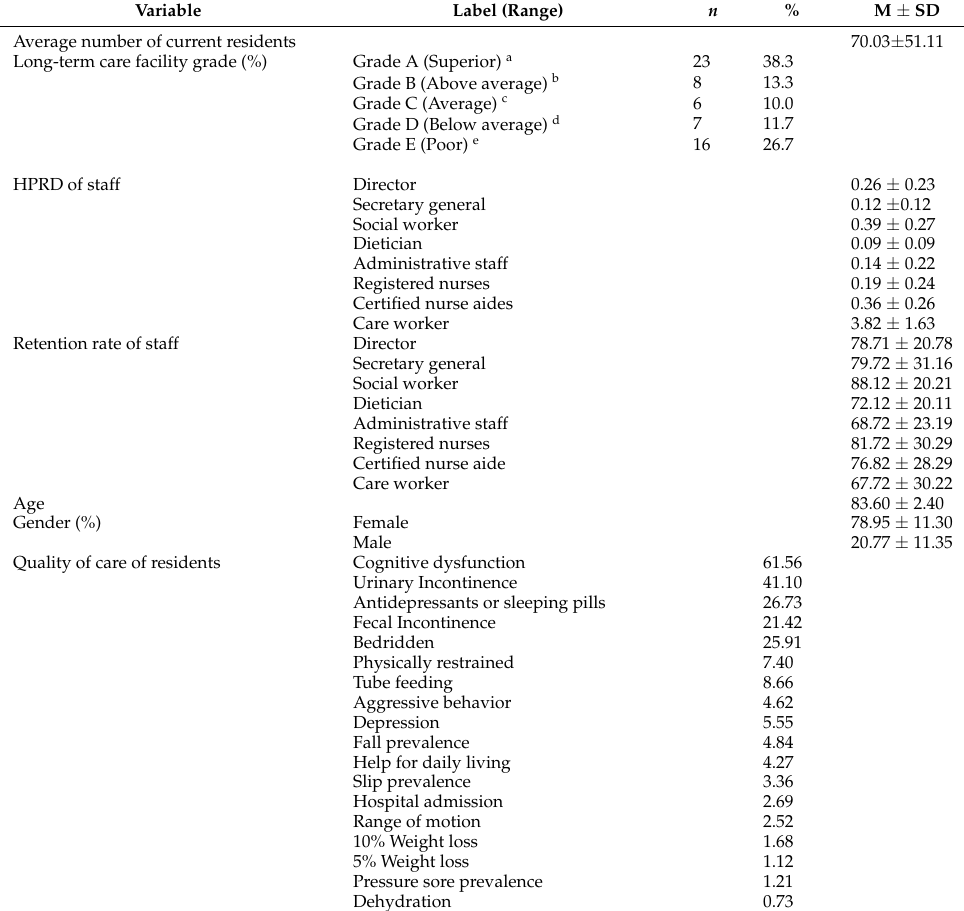
Table 2. Characteristics of Nursing